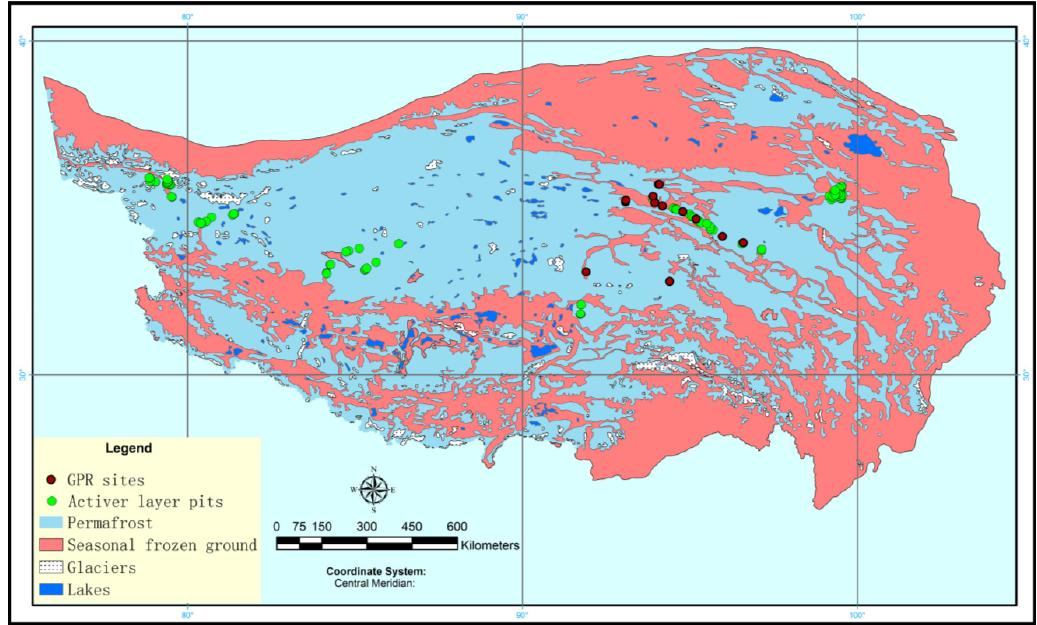
Figure 14. Spatial distribution of our GPR detection soil sample sites and all the active layer pits for organic content and soil bulk density analysis. organic content and soil bulk density analysis.